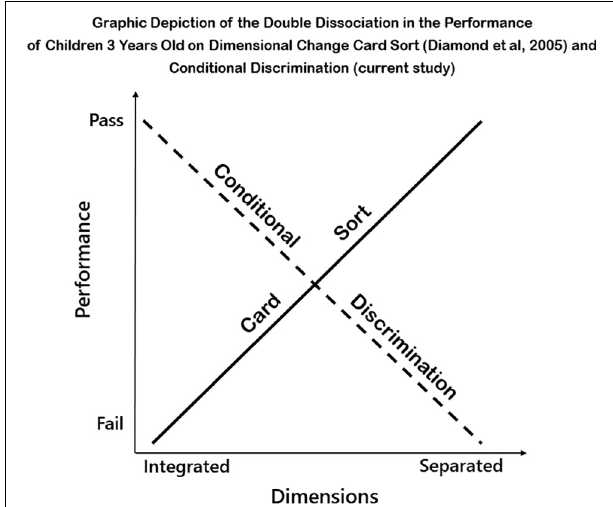
FIGURE 5 | Graphic depiction of the double dissociation in the performance of children 3 years old on dimensional change card sort (Diamond et al., 2005) and conditional discrimination (current